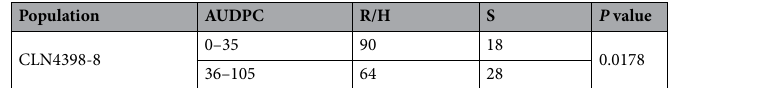
Table 5. Association between the phenotypic response when inoculated with the Pss4 isolate of bacterial wilt (race 1, biovar 3, Ralstonia pseudosolanacearum ) of the CLN4398 F 2 population and the Bwr3.2dCAPs molecular marker determined by Fisher’s Exact Test in